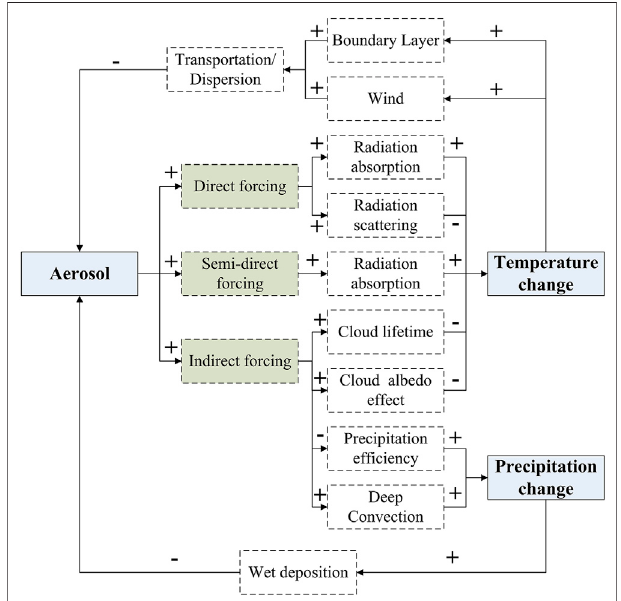
FIGURE 1 | Framework of aerosol-climate interaction. The blue and green blocks refer to the state variables and their in fl uences. The white blocks are the auxiliary variables that connect the state variables. The “ + ” and “ − ” symbols represent positive and negative correlations, respectively. Positive or negative feedback cycles can be identi fi ed by the even or odd occurrence of “ − ”